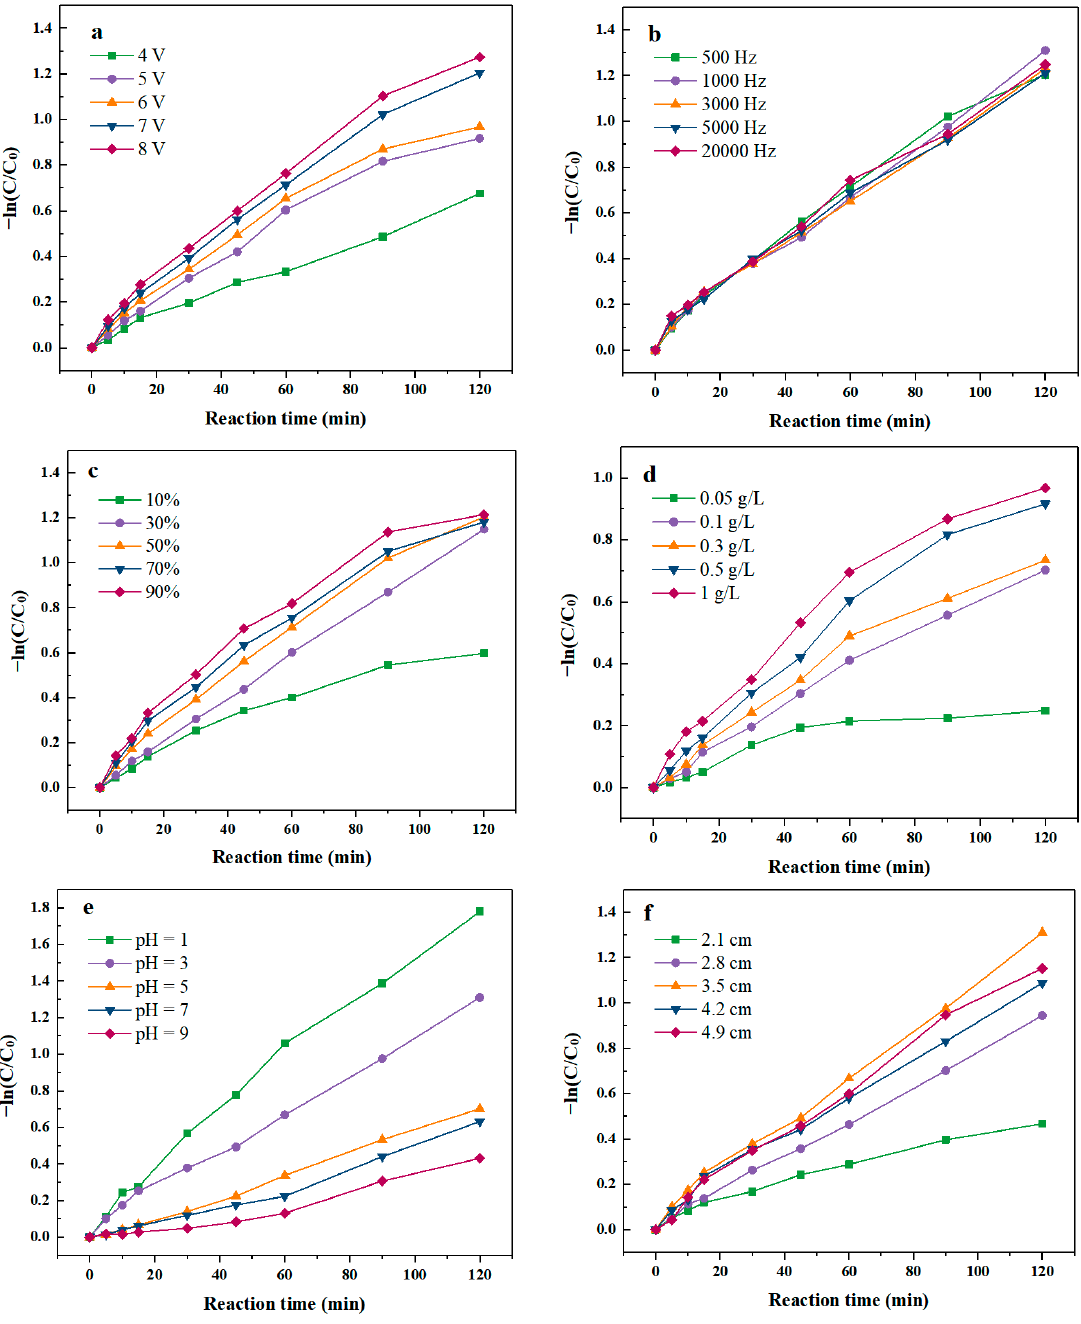
Figure 1. Effect of operation parameters on degradation rate of SND. ( a ) Voltage of PEF; ( b ) Frequency of PEF; ( c ) Duty cycle of PEF; ( d ) Initial PMS concentration; ( e ) Initial pH value; ( f ) Electrode inter distance.